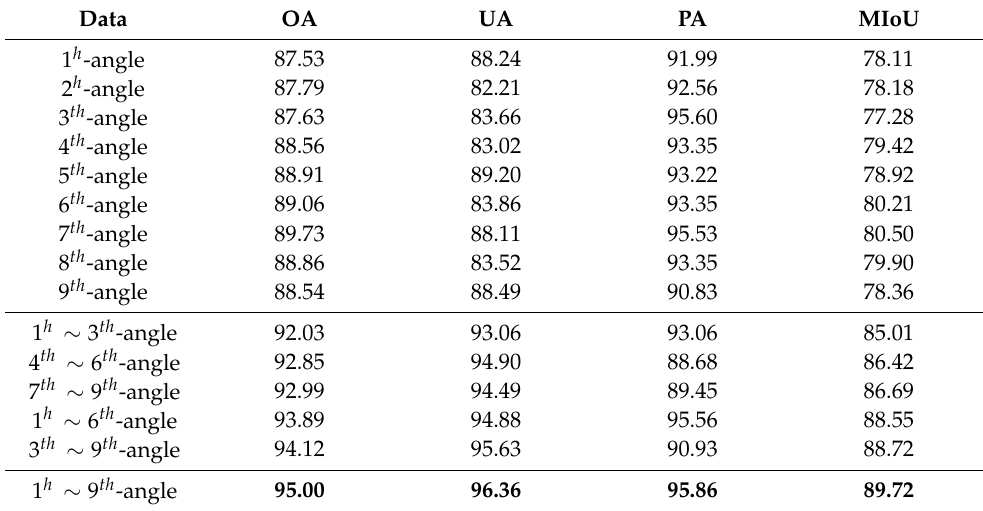
Table 6. The cloud detection accuracy (%) of different input angles.